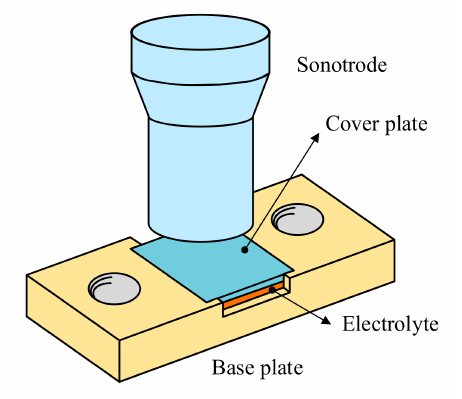
Figure 5. Schematic of the ultrasonic